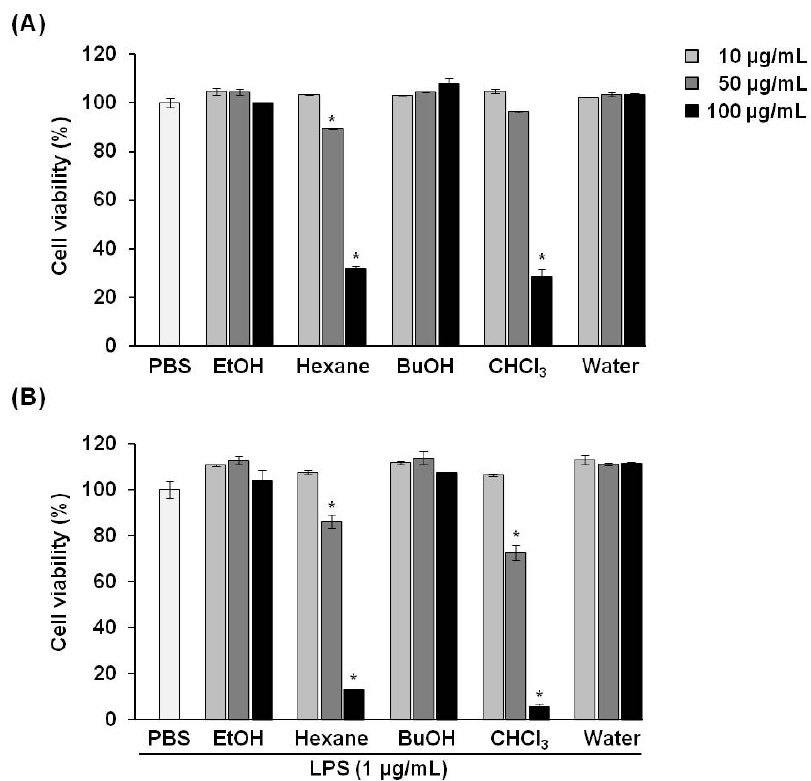
Figure 1. Effects of solvent fractions from Prunella vulgaris var. lilacina on the viability of RAW 264.7 cells. ( A ) Lipopolysaccharide (LPS) untreated; ( B ) LPS treated. Bars represent the mean and standard deviations from three different experiments performed in triplicate. * p < 0.05 significantly different from the LPS